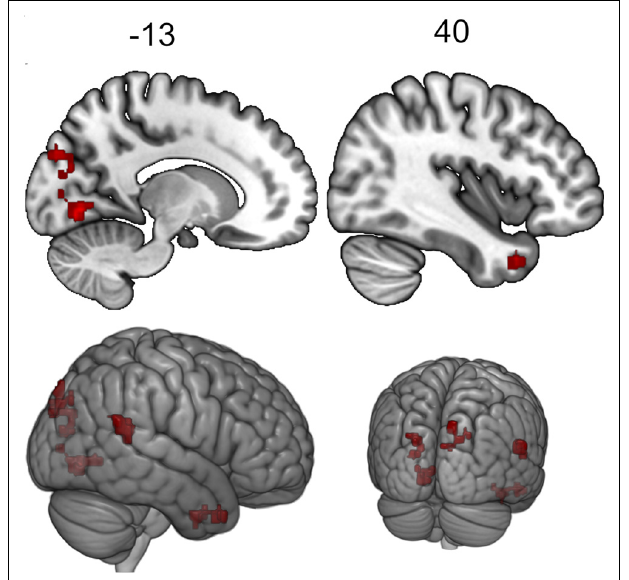
FIGURE 3 | Clusters showing increased connectivity with the right posterior temporal fusiform cortex after neurofeedback. The connectivity map for intrinsic connectivity contrast post- vs. pre-neurofeedback is thresholded at p -FDR < 0.008 at the cluster-level with a cluster-defining voxel-wise statistical threshold of p < 0.001 uncorrected.